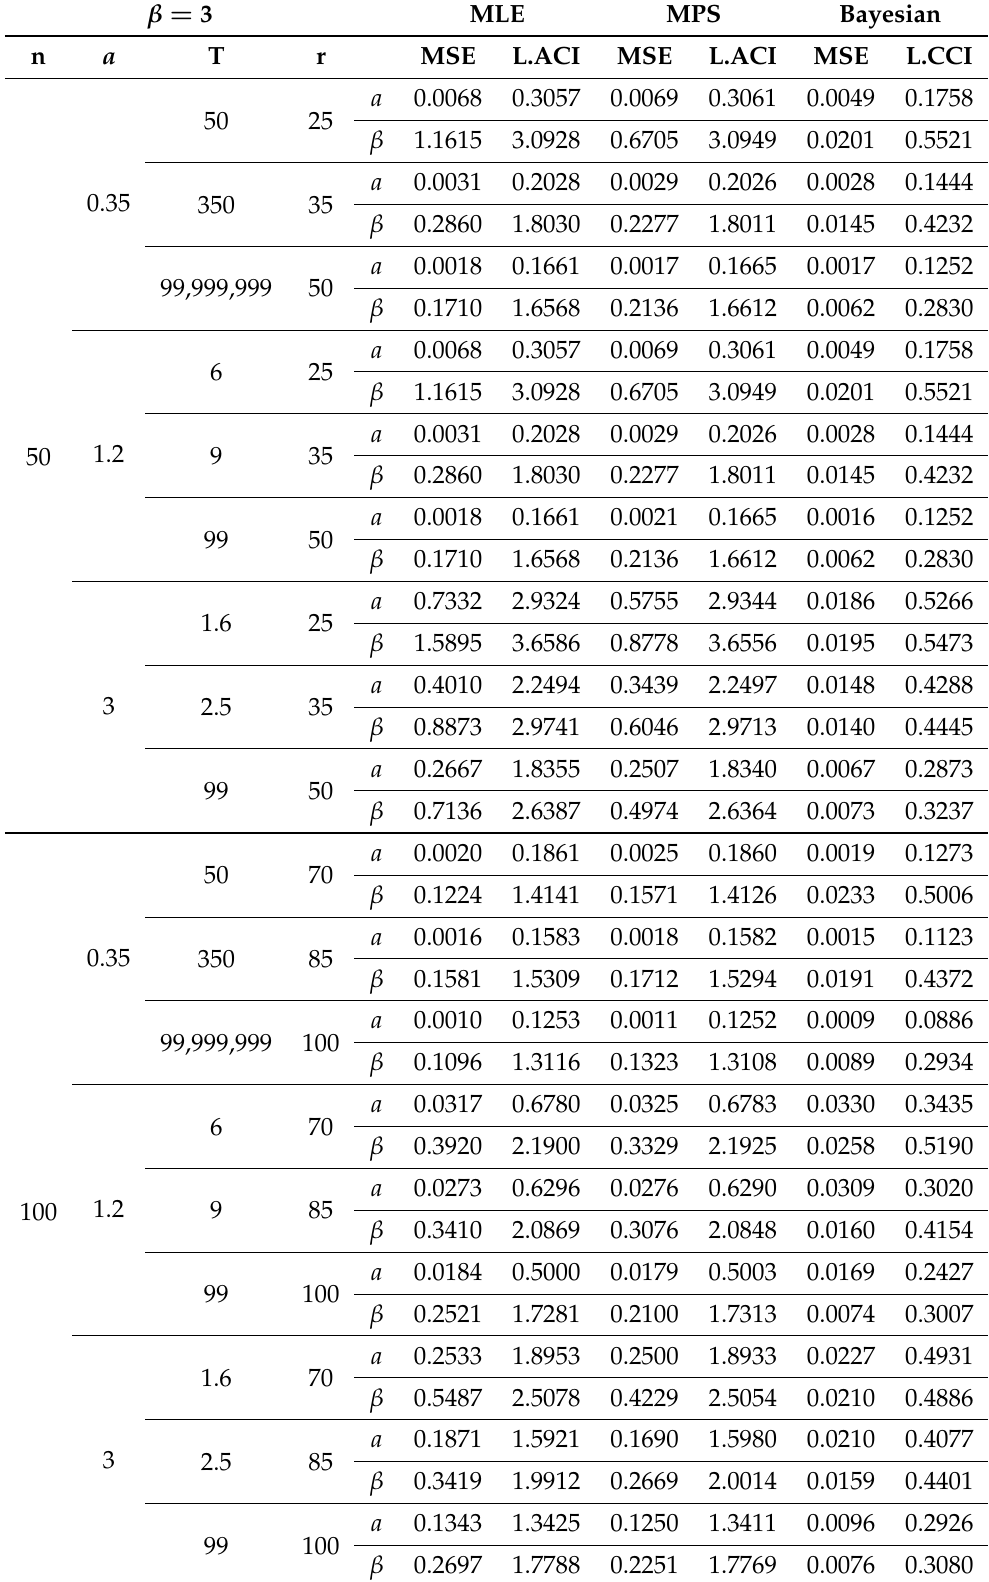
Table 6. MSE and length of CI for MLE, MPS, and Bayesian estimation for parameter of the TCP-ITL based on hybrid censored samples: when β =